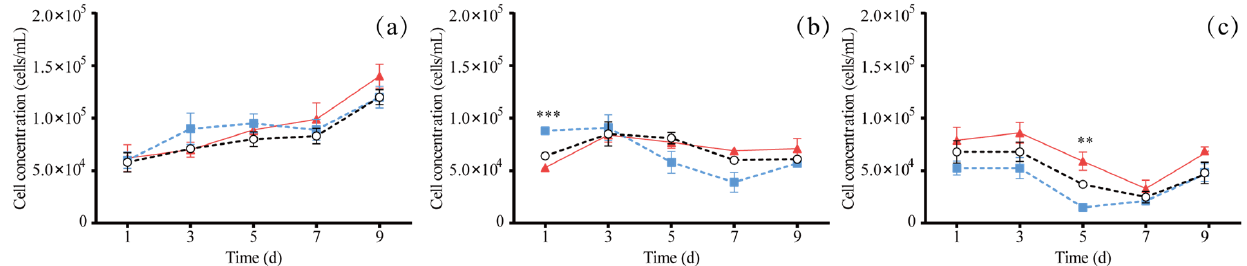
Figure 2. Cell concentration curves of H. lacustris under light intensities of ( a ) 18 μ mol/m 2 ·s, LL; ( b ) 55 μ mol/m 2 ·s, ML; ( c ) 110 μ mol/m 2 ·s, HL. Treatments are white (open circle), blue (blue box), and red (red triangle) LED lights. Error bars show the standard deviation for three replicates. Asterisks indicate statistically significant differences resulting from Student’s t -tests: ** p < 0.01, *** p < 0.001.